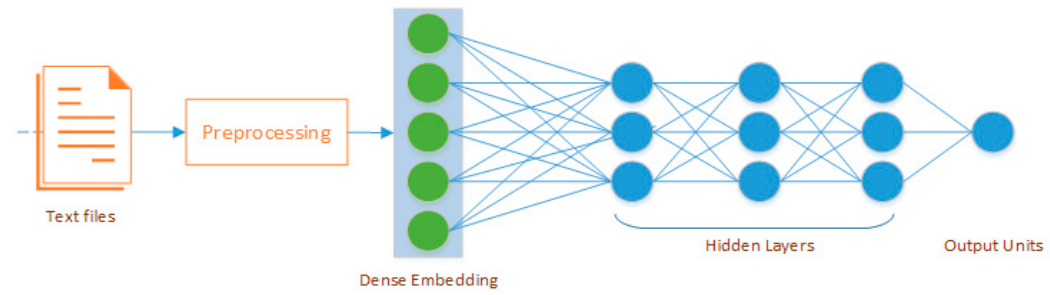
Figure 3. Process identifying ‘deep features’.